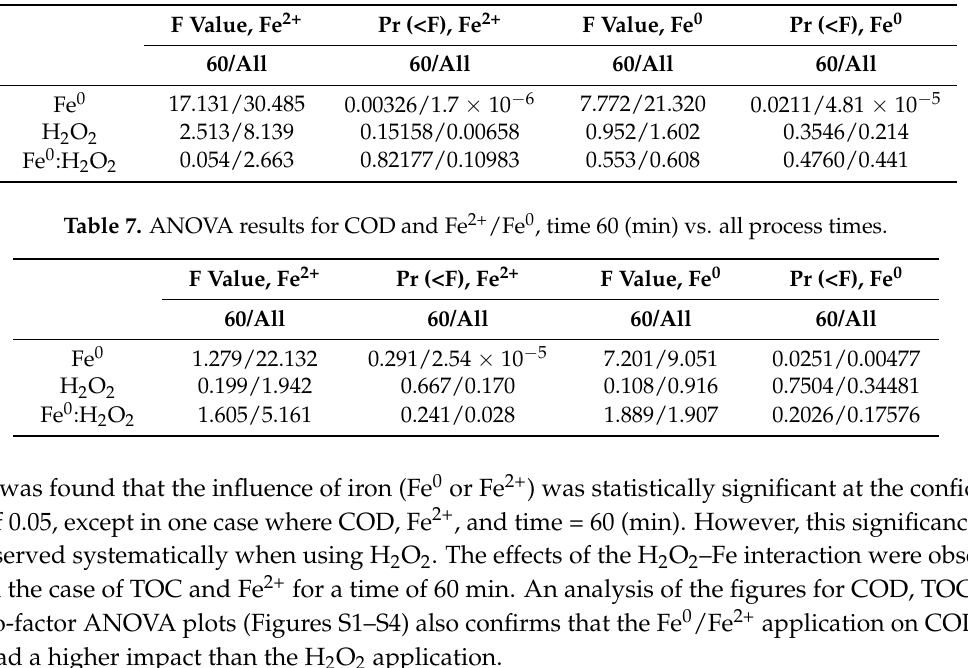
Figure S1. Main effects and 2-way interactions for TOC, for Fe 0 and all process times. Figure S2. Main effects and 2-way interactions for TOC, for Fe 0 and time 60 min. Figure S3. Main effects and 2-way interactions for TOC, for Fe 2+ and all process times. Figure S4. Main effects and 2-way interactions for TOC, for Fe 2+ and time 60 min. Table S1. FGD wastewater coagulation treatment results. FeCl 3 dose (100 mg/L), pH = 8.5, TMT dose ( µ L/L), Flocculent dose (mg/L), A = AN913SH, FGD = polymer used in power plant, COD, TOC, B and heavy metals (mg/L). Table S2. Heavy metals concentration after Fe 2+ /H 2 O 2 process after sedimentation. Table S3. Heavy metals concentration after Fe 0 /H 2 O 2